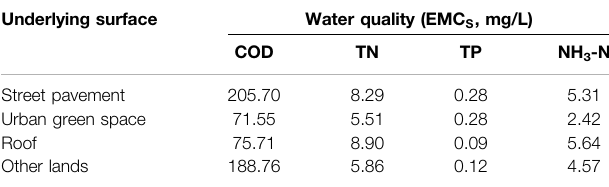
TABLE 4 | Annual event mean concentrations ( EMC S ). Underlying surface